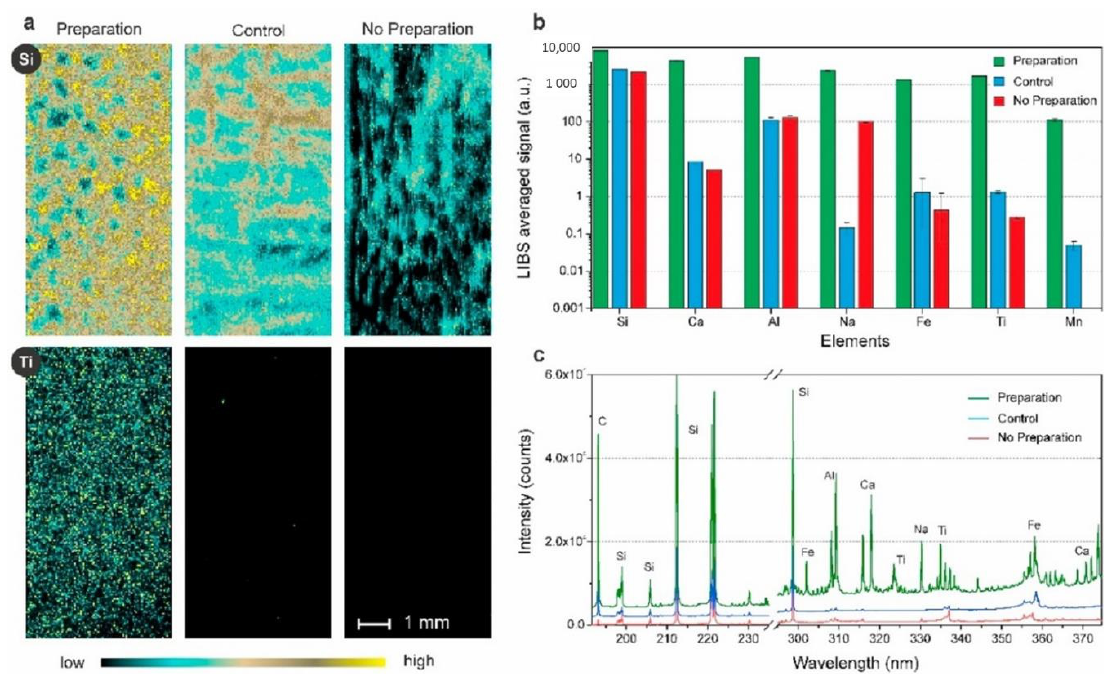
Figure 5. ( a ) Distribution imaging of Si and Ti in an Antarctic PM filter sample following the preparation protocol and no preparation. The control sample was prepared following the preparation protocol. ( b ) Average LIBS signal associated with some elements for the three different scenarios (preparation, control, and no preparation). ( c ) Average LIBS spectrum of the three scenarios in two spectral ranges (180 – 253 nm and 290 – 379 nm) [113] .